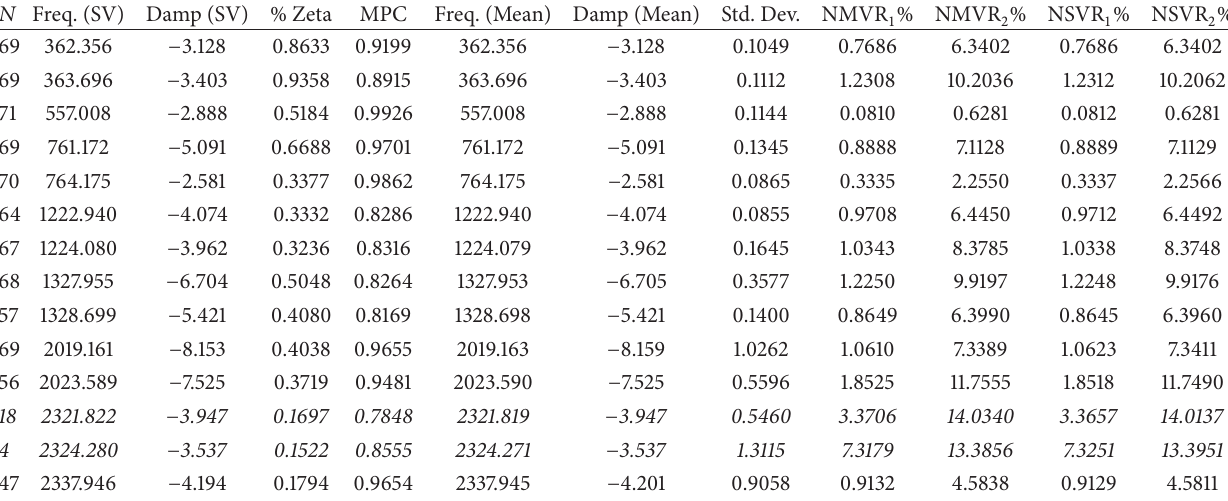
Table 3: Summary of autonomous modal parameter estimation